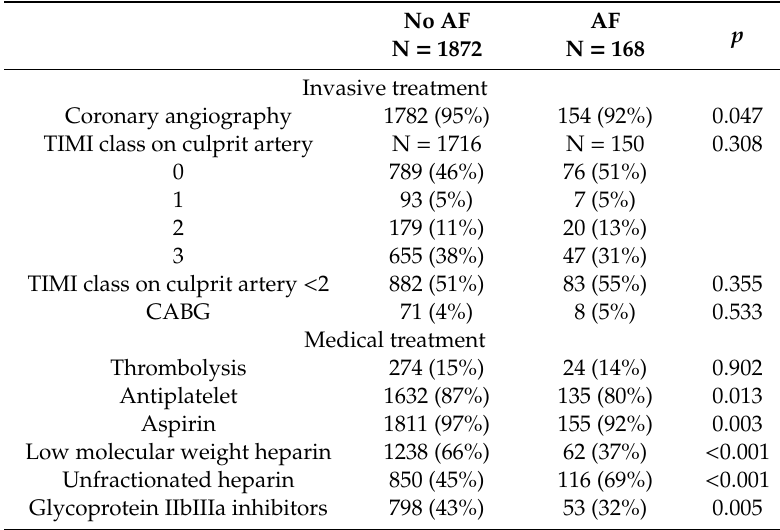
Table 2. Acute myocardial infarction management (n (%)).